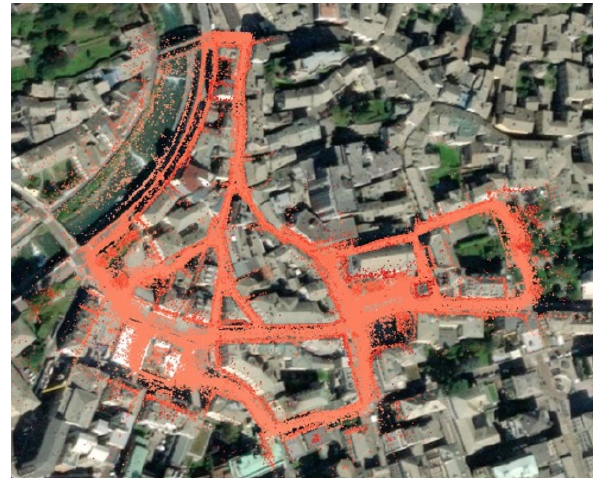
Figure 2: The points used for image orientation visualized on a satellite orthophoto.